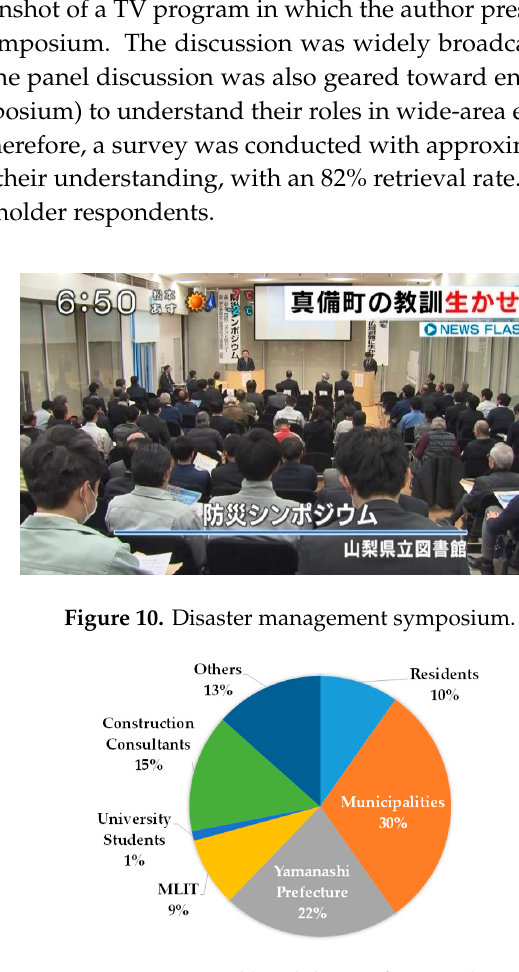
Figure 11. Sectoral breakdown of respondents.